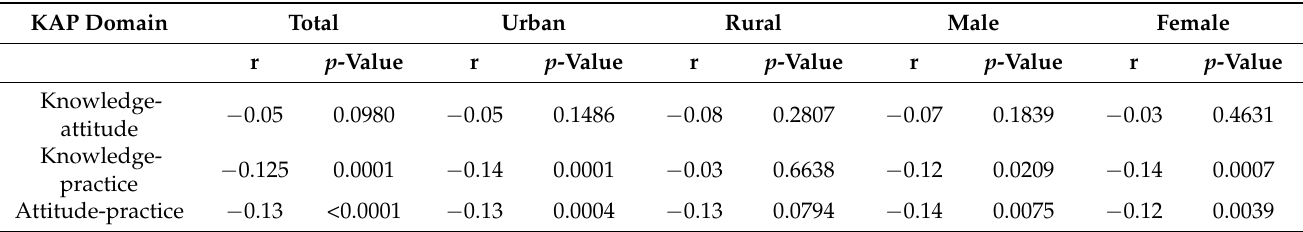
Table 5. Correlation of KAP and locality of